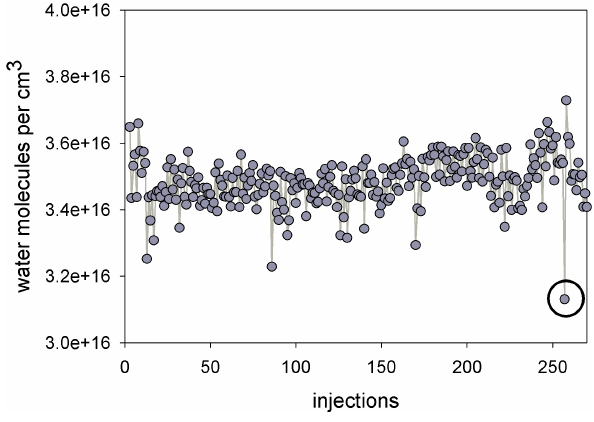
Fig. 6. Example of inconsistent